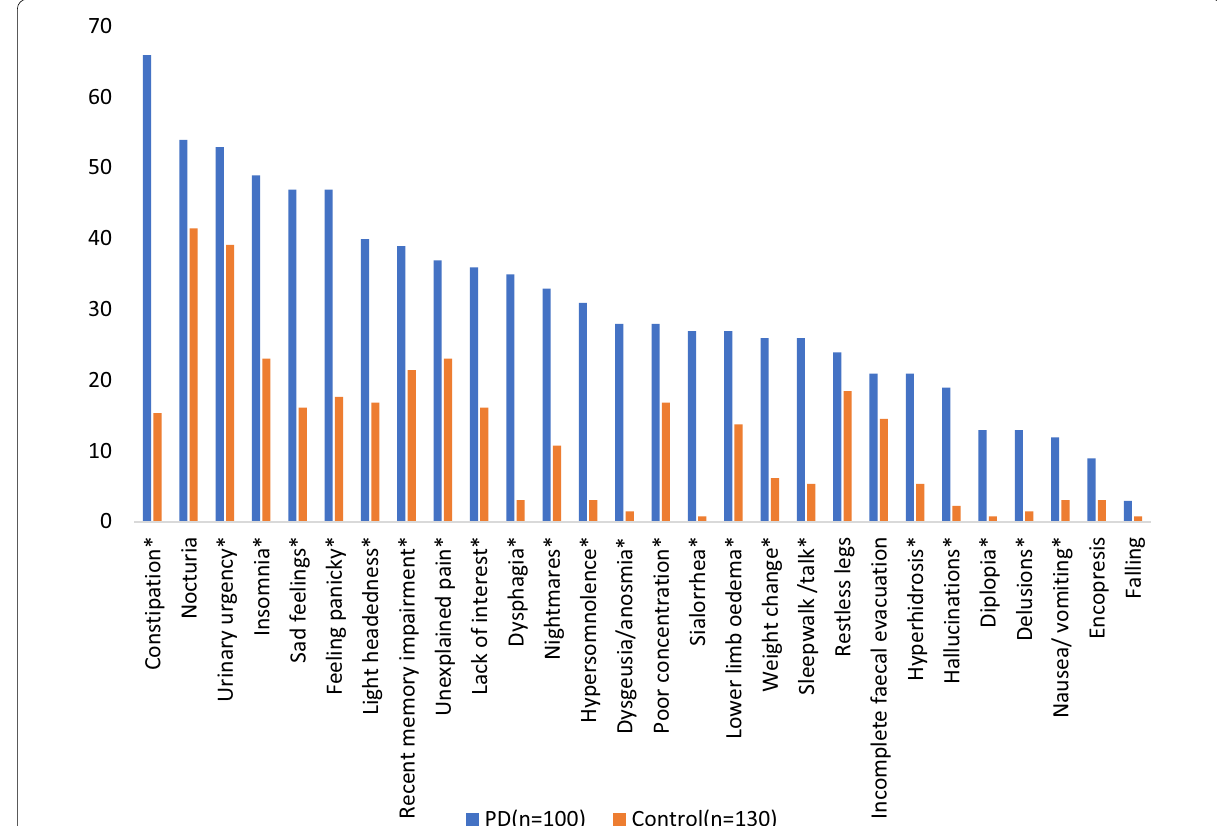
Fig. 2 The frequencies of non-motor manifestations in Parkinson’s disease patients and control group. * Indicates p < 0.05. Only 5 out of 28 features were not more prevalent in PD compared to